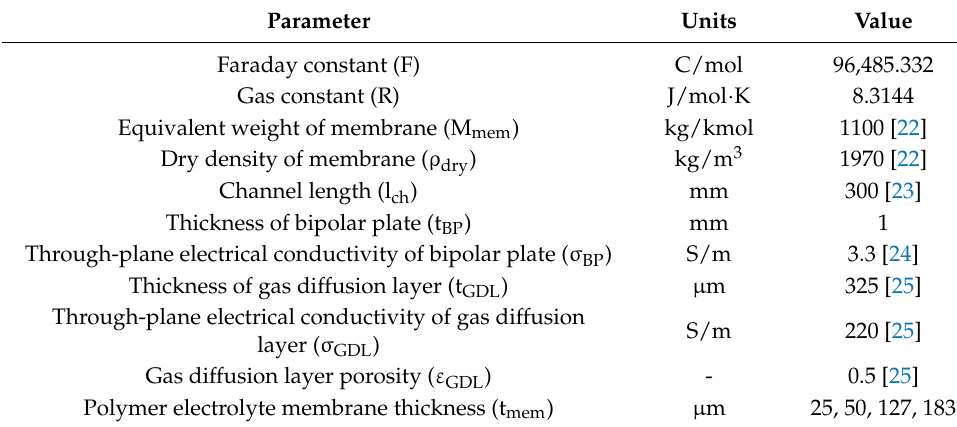
Figure 2. Pseudo-two-dimensional model of the electrochemical hydrogen compressor. Table 1. Physical parameters and geometrical properties of EHC.